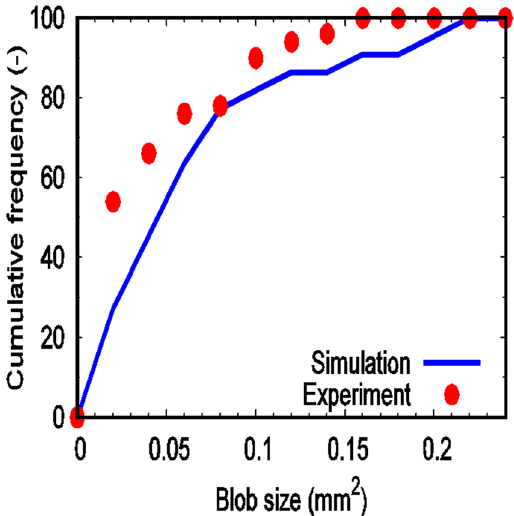
Figure 3. Comparison between the blob-size distributions computed numerically and the ones measured by the microfluidic experiments for the fluids PMX – 200 Silicone Fluid and water with water injection rate of 1.0